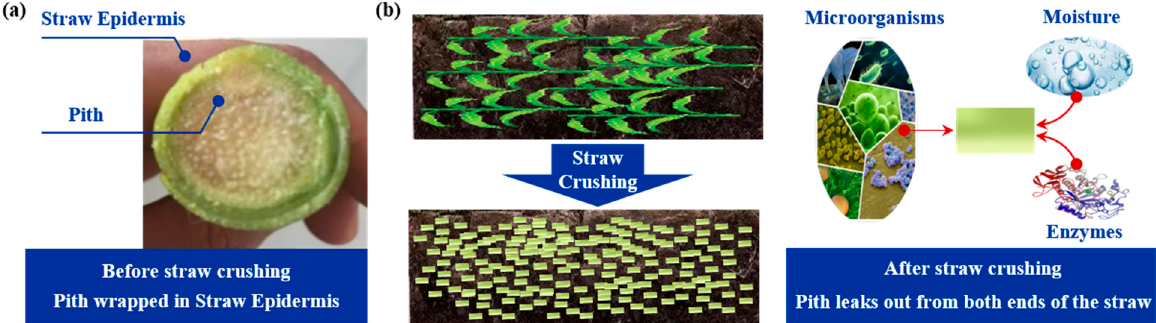
Figure 7. ( a ) Diagram of maize straw composition. ( b ) Straw relies on the pith part to absorb water, microorganisms, enzymes and other substances in the soil.